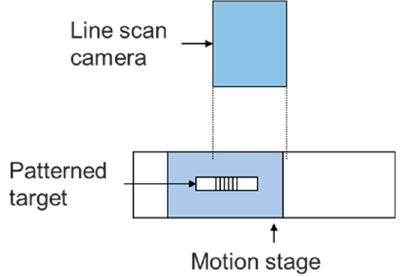
Figure 1. Schematic of an image grating system.